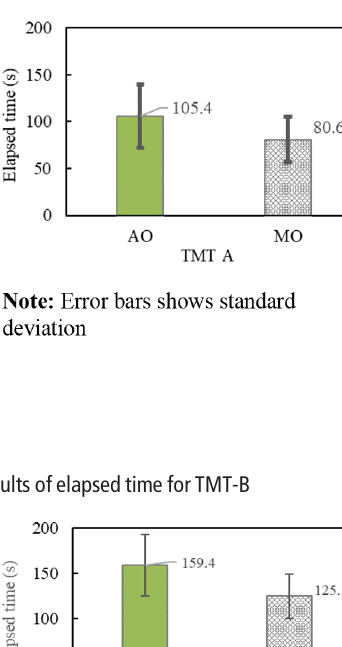
Figure 6 Results of elapsed time for TMT-A